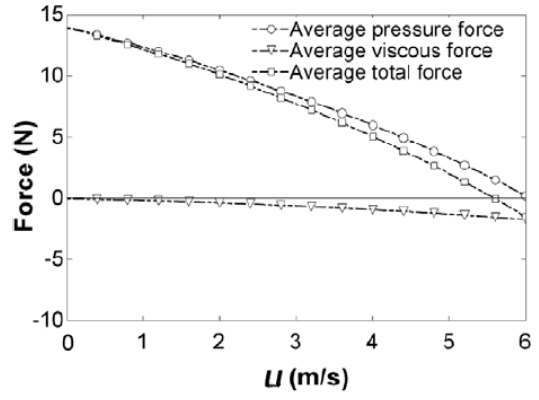
Figure 6. Average forces against cruising velocity for anguilliform swimming [50]. Reproduced or adapted from [50], with permission from Elsevier,